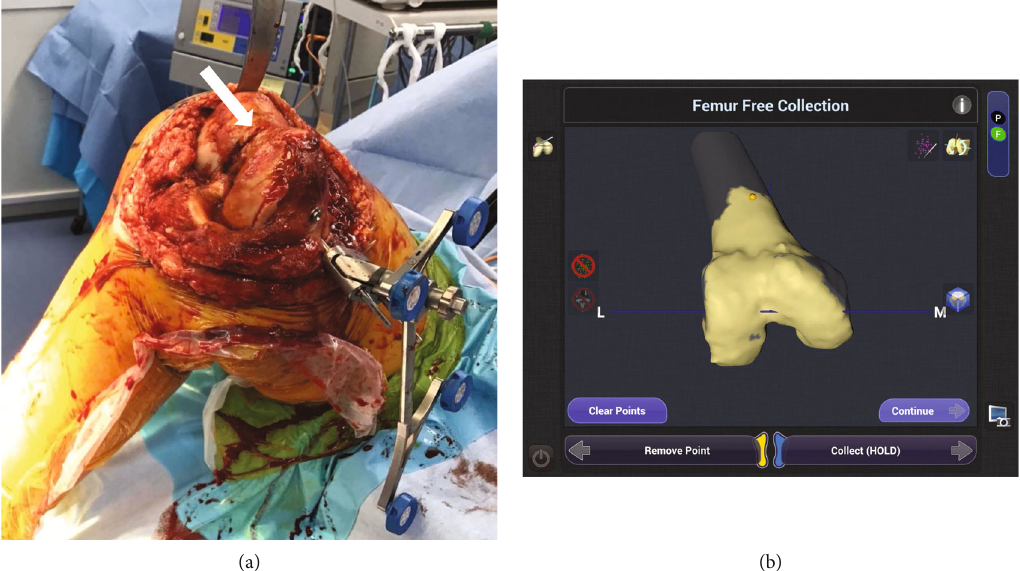
Figure 3: The fracture line (white arrow) is fi xed using two bury pin threads (4.0 mm) and anatomy of the femoral condyle were mapped by “ painting ” the surfaces with an optical probe. The surface was coated with an optical probe, but it was reduced and there was no separation of the fracture. (a) Intraoperative photograph and (b) image free registration.